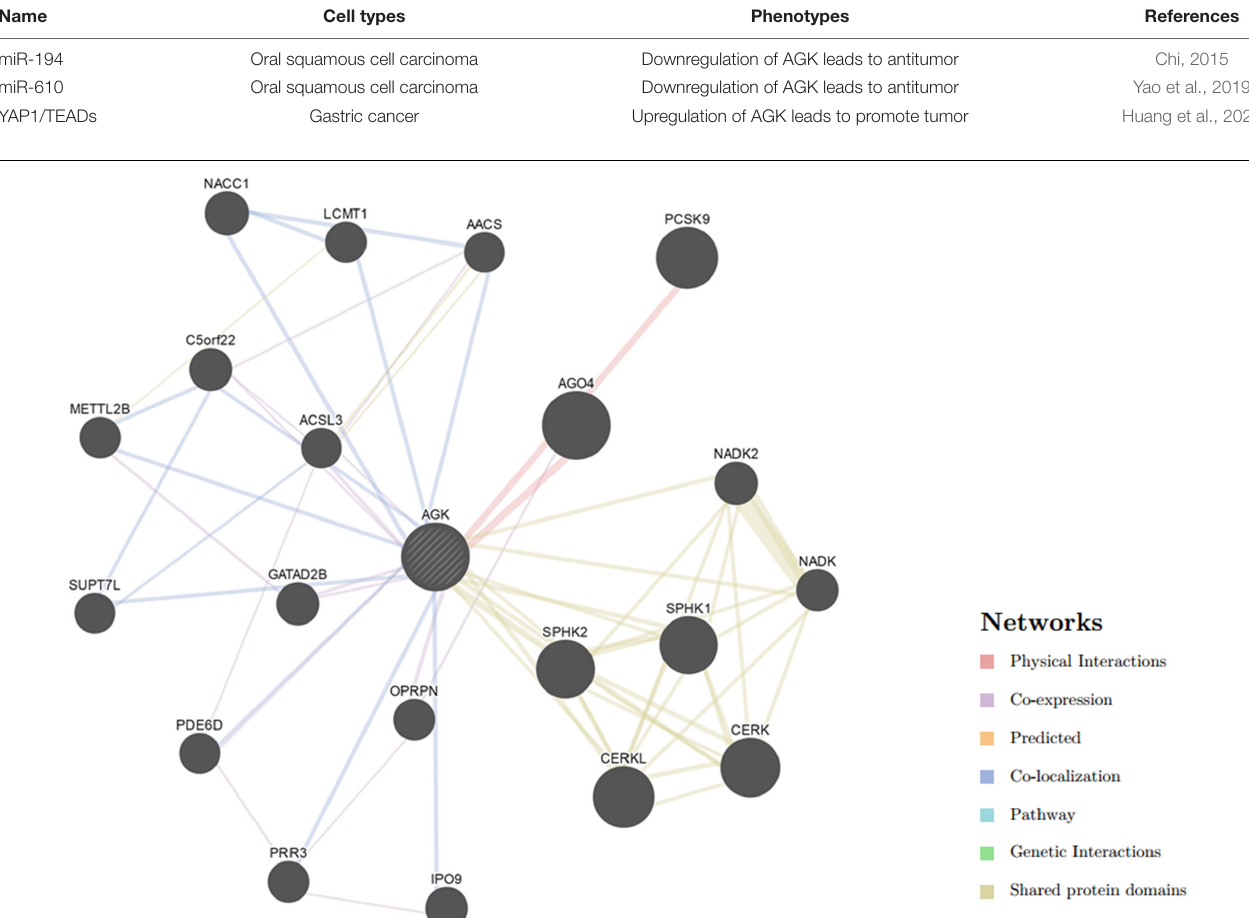
TABLE 1 | List of factors reported regulating AGK expression or activity.